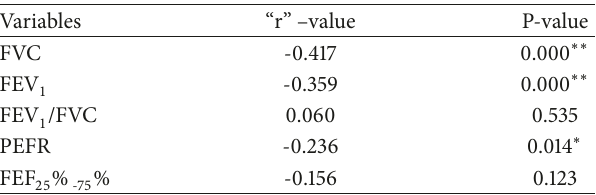
Table 6: Pearson correlation coefficient results between pulmonary function parameters and duration of exposure.